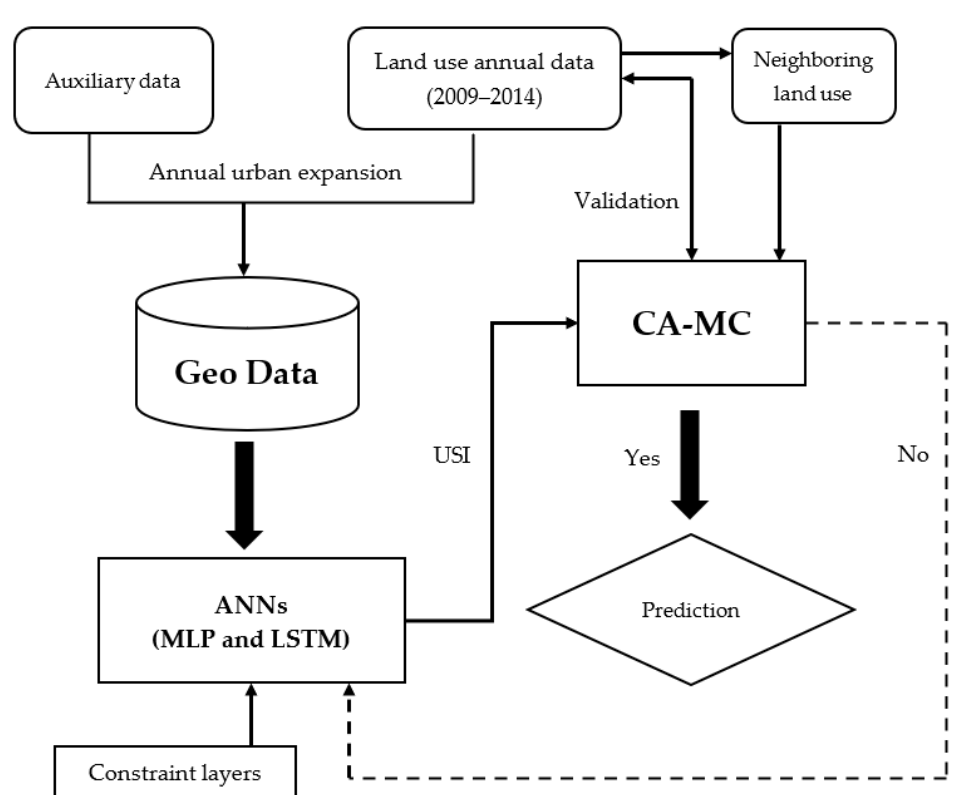
Figure 3. ANN–CA–MC framework for modeling urban expansion in the Liangjiang District of Chongqing, China.